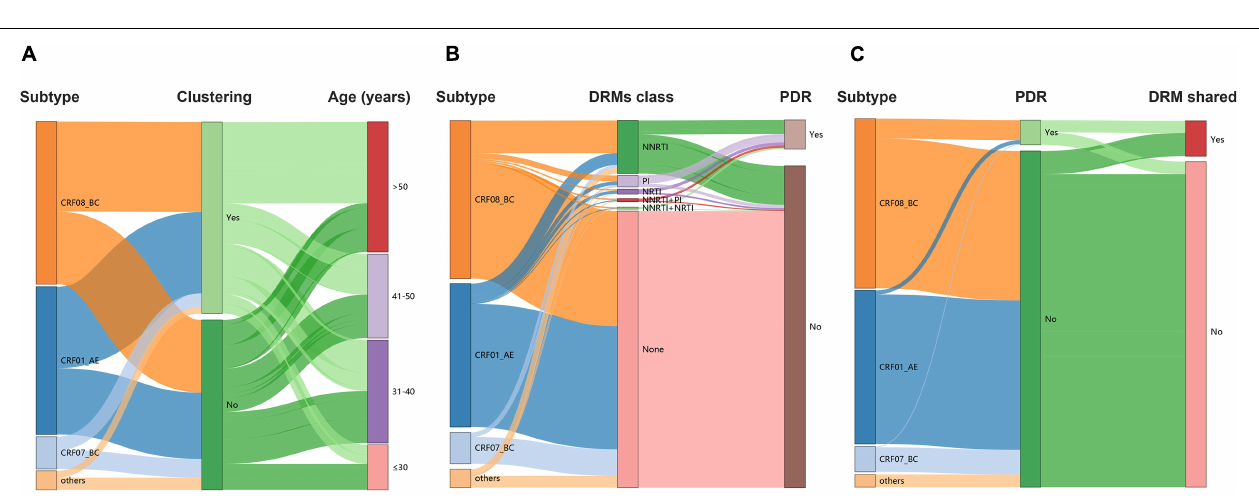
FIGURE 3 | HIV-1 TCs of PDR for three major subtypes. (A) Genetic network for CRF01_AE and all edges represent a GD of < 1.4%. (B) Genetic network for CRF08_BC and all edges represent a GD of < 1.2%. (C) Genetic network for CRF07_BC and all edges represent a GD of < 1.6%. Squares and circles denote male and female. Nodes color indicates the reported transmission route and the frame color indicates the sampling city. Edges in bold red indicate individuals who shared DRM. And shared DRM were labeled with each node.